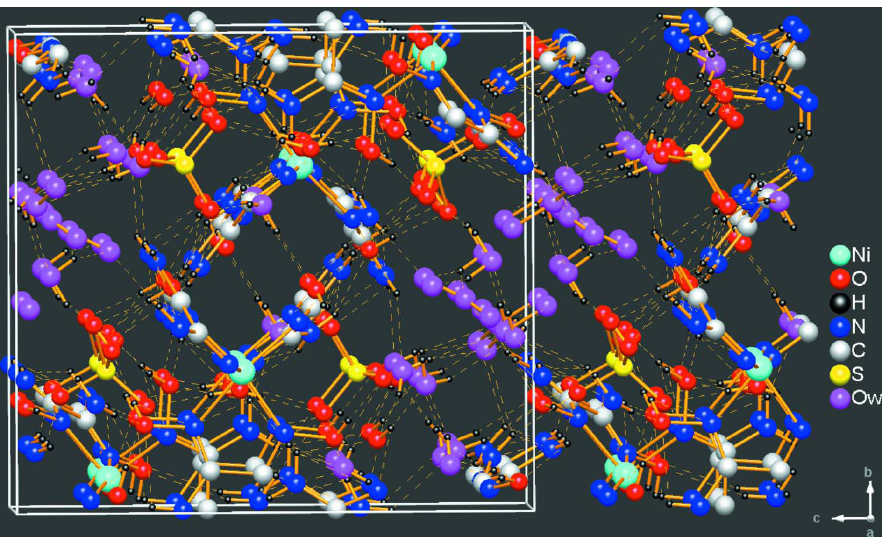
Figure 2 Crystal sructure of the title compound, viewed down the a axis. Hydrogen bonds are shown as dashed